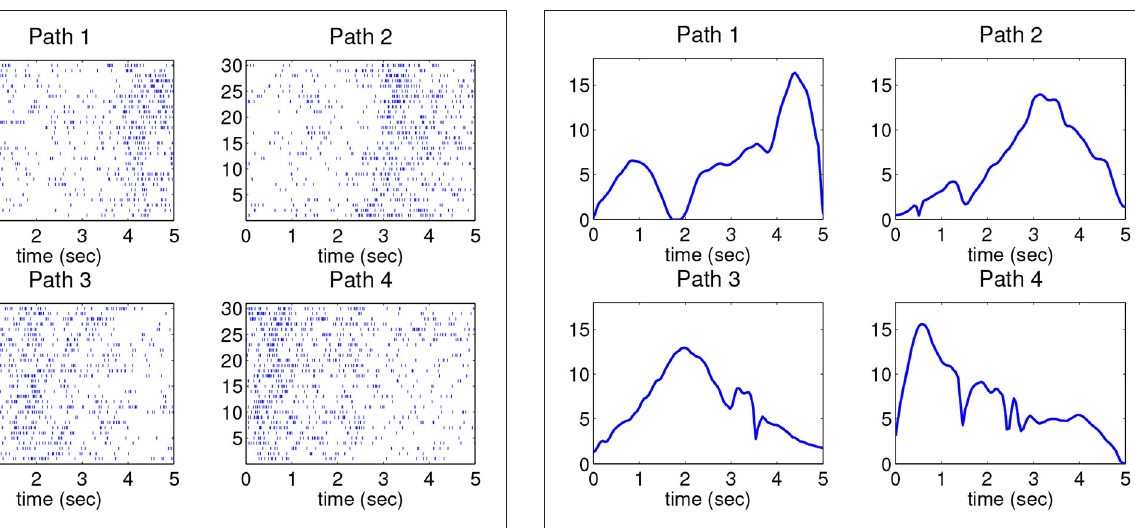
overlapping. Each sequence of 5 targets defined a path, and there were four different paths in the SP task (depending on the starting point). In this experiment, 60 trials for each path were recorded, and the total number of trials was 240.